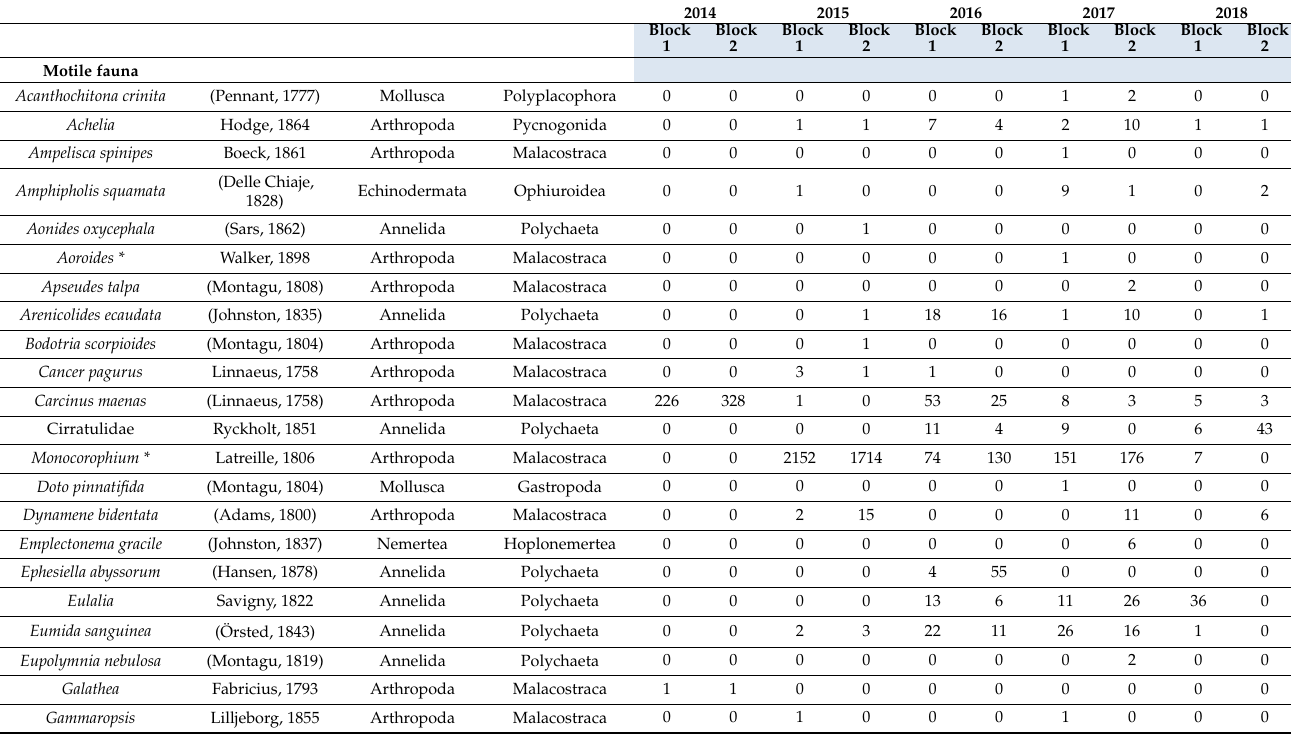
Table A1. List of the collected taxa with their abundance per 0.6 m 2 for the ten blocks analysed from 2014 to 2018. * Non-Indigenous